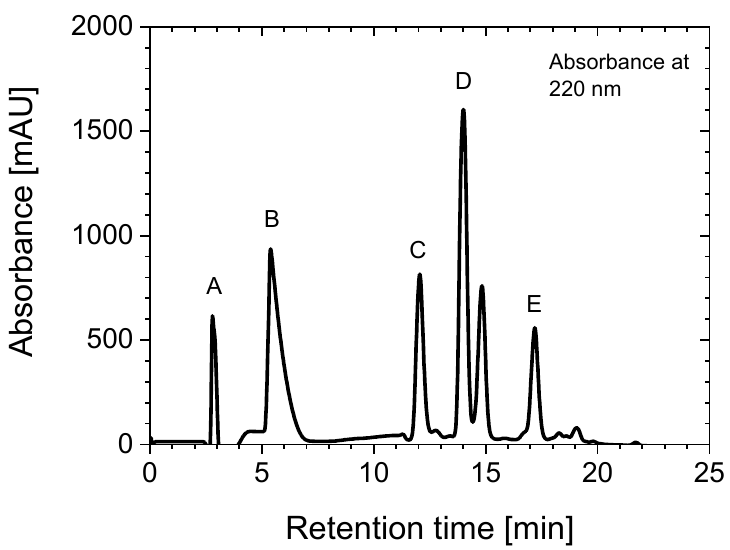
Figure 7. HPLC chromatogram of a crude reaction solution yielding [Al(OH)(NODA*)] (D). Other species: (C) = NODA* and (E) = impurity of the delivered NODA*. (A) = free aluminum and (B) gradient peak. Detection modes: Gamma (NaI) and UV (220 nm). Gradient: 1–25 min: 100% 0.1 M TFA aq → 100% MeCN. Column: PRP-1-10 # (250 × 4 mm, CS-Chromatographie Service, D-52379 Langerwehe), flow: 2 mL/min. # ) Resin was from HAMILTON (Reno, NV, USA).